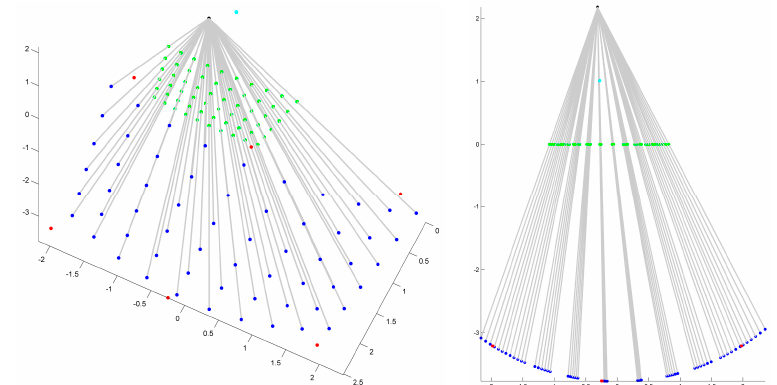
Figure 5. Spatial positioning of devices and 3D points, where the different coloured dots represent: black: camera projection center; cyan: projector projection center; red: control points at the cylindrical surface; green: checkerboard points at Z = 0; blue: checkerboard points at the cylindrical surface.